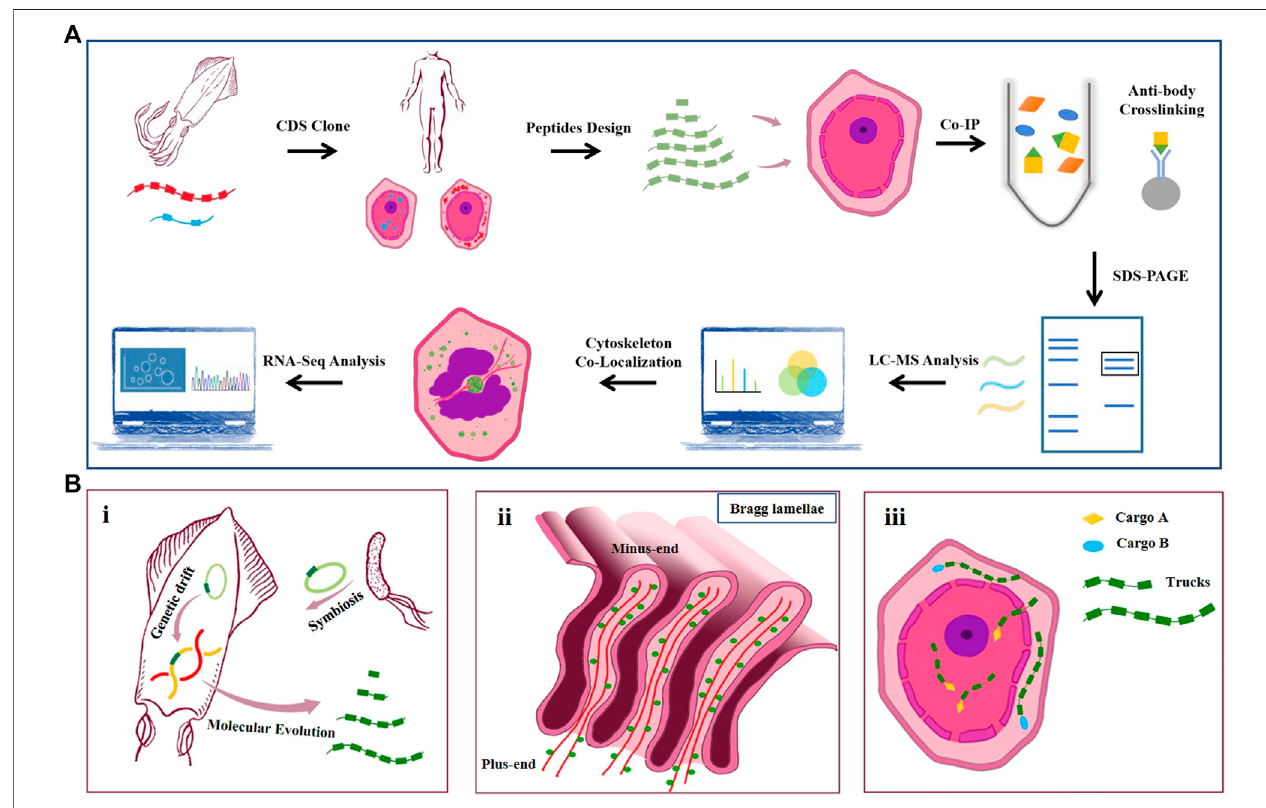
FIGURE 7 | (A) Schematic of the work fl ow. CDS of squid re fl ectin proteins are obtained from NCBI. Codons are optimized according to mammal cell expression preference and introducedinto HEK-293T cells bylipofection. RfA1 truncated variants are designed and cloned intopEGFP-C1 vectors. Anti-GFP monoclonal antibody is used to pull down GFP-tagged RfA1 variants and their binding proteins. Immunoprecipitates are separated using SDS-PAGE. Gel lanes are digested with trypsin for LC-MS/MSanalysis.ColocalizationofRfA1andactincytoskeletoniscon fi rmedbyconfocalmicroscope.RNA-Seqisemployedtogloballyinvestigatethein fl uence of RfA1 expression on cells. (B) . Illustration for hypothetically models. i. Origin and evolution of re fl ectin proteins. ii. Microtubule minus-end-directed transportation of re fl ectin. iii. Schematic for RfA1 derivatives as programmable and oriented cargo carriers.